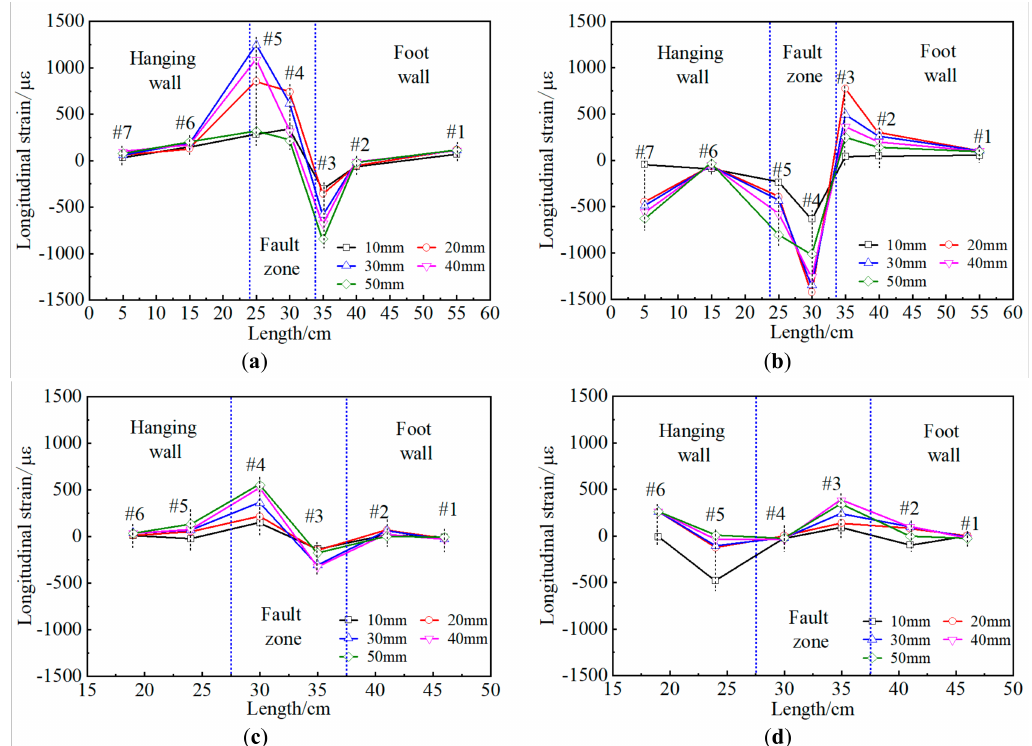
Figure 10. Longitudinal strain of a tunnel under different fault displacements. ( a ) lining without joints, left wall; ( b ) lining without joints, right wall; ( c ) lining with joints, left wall; ( d ) lining with joints, right